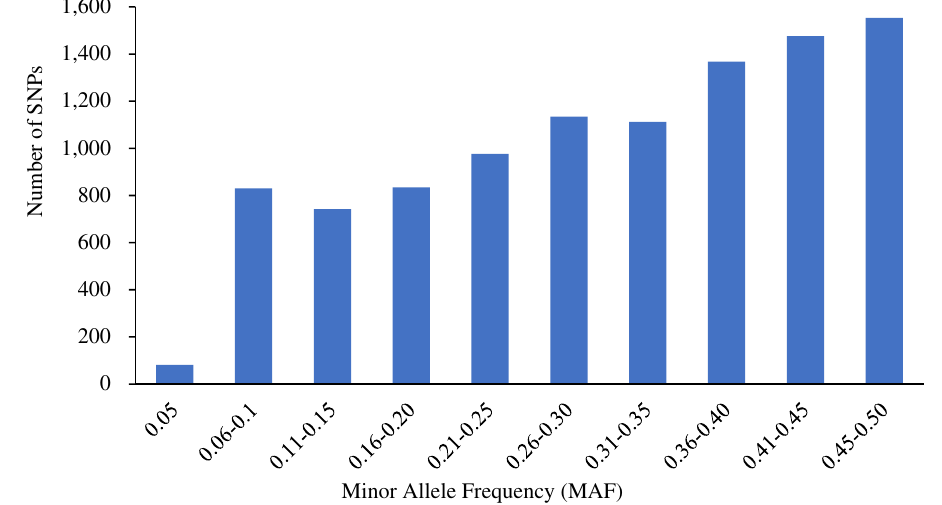
Figure 2. Distribution of minor allele frequency (MAF) of 10,106 SNPs in 214 tetraploid clones.